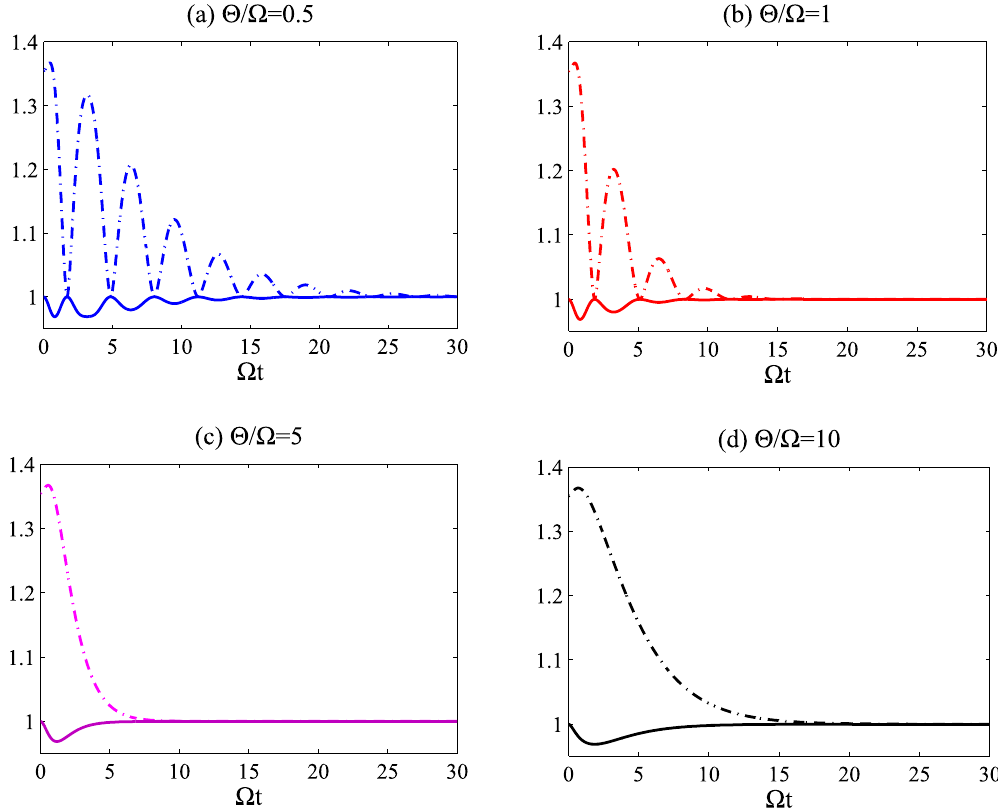
Figure 6. The variation of the uncertainty for the measurement and the purity of the evolutive system — in the absence of quantum memory — with respect to the dimensionless time ( Ω t ) for different coupling-strength ratio of Θ Ω / for an initial state constructed with θ π = /3 and φ π = /6 . In the Figure, the dash-dotted lines represent the uncertainty, and the solid lines represent the purity of the evolutive state of the qubit. Graphs ( a – d ) are plotted with Θ Ω / set to 0.5, 1.0, 5.0 and 10,